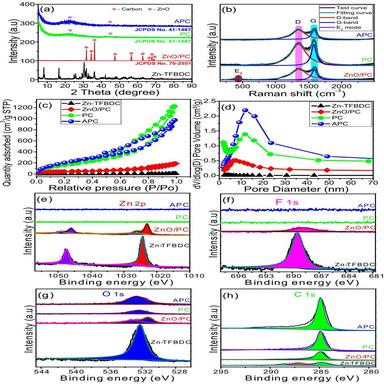
(a) XRD patterns, (b) Raman spectra, (c) nitrogen adsorption-desorption isotherm and (d) pore size distribution and (e-h) high resolution XPS spectra: (e) Zn 2p, (f) F 1s, (g) O 1s, and (h) C 1s of obtained Zn-TFBDC, ZnO/PC, PC and APC samples.